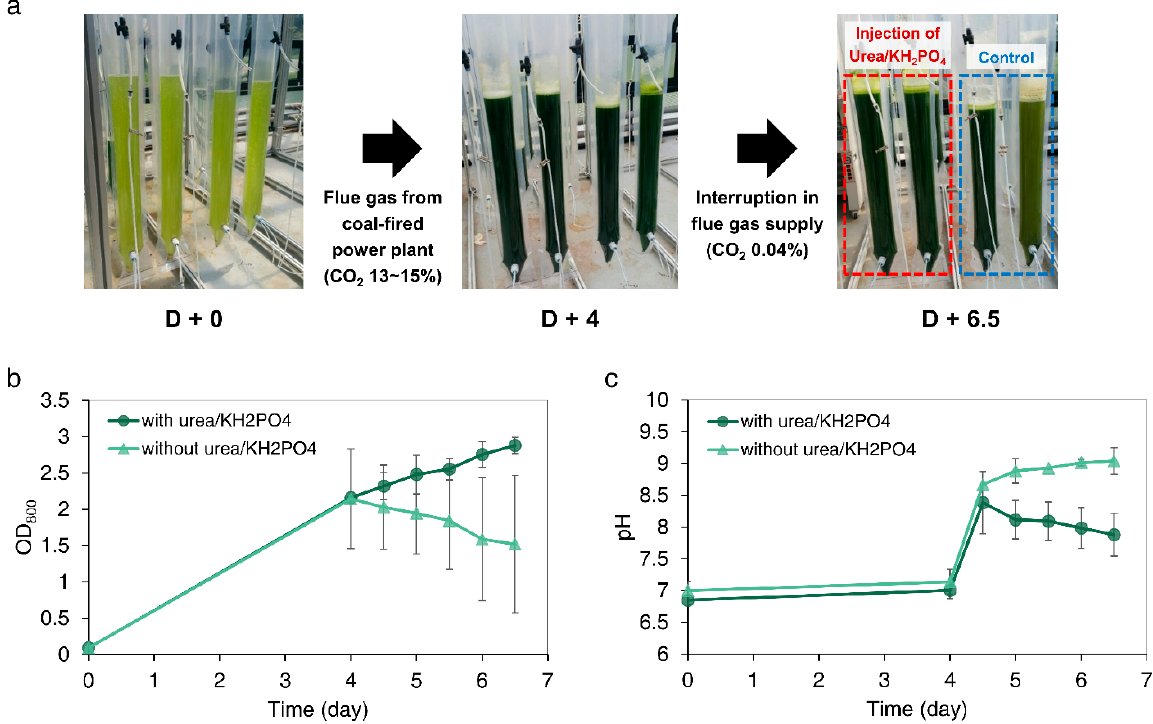
Figure 6. Outdoor cultivation of Chlorella sorokiniana UTEX 2714 using flue gas from coal-fired power plant. ( a ) Images of 10-L bubble column polymeric photobioreactor during cell culture. Changes of ( b ) optical density (OD) and ( c ) pH of the medium for 6.5 days of cell cultivation. Algal cells were cultivated using flue gas (CO 2 13~15%) for 4 days and with supplementation of urea and KH 2 PO 4 under interruption in flue gas supply for 2.5 days. Results represent the mean ± standard deviation (SD) of three replicates.